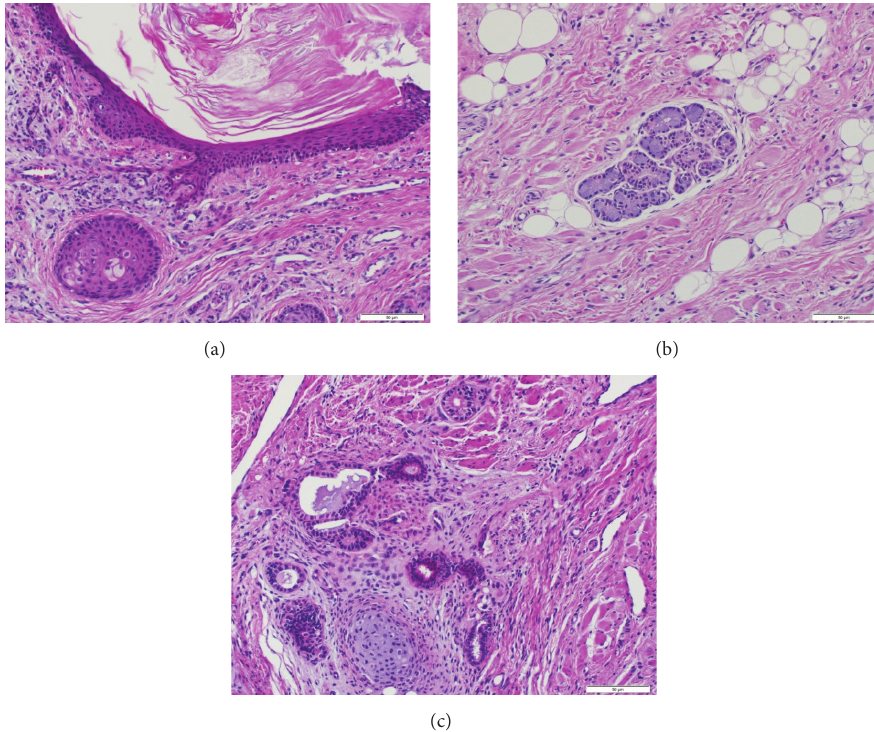
Figure 3: (a) Microscopic images showing cystic spaces lined by keratinized squamous epithelium; (b) skeletal muscle and salivary type glandular epithelium; (c) skeletal muscle, well differentiated cartilage, and epithelium lined glandular spaces